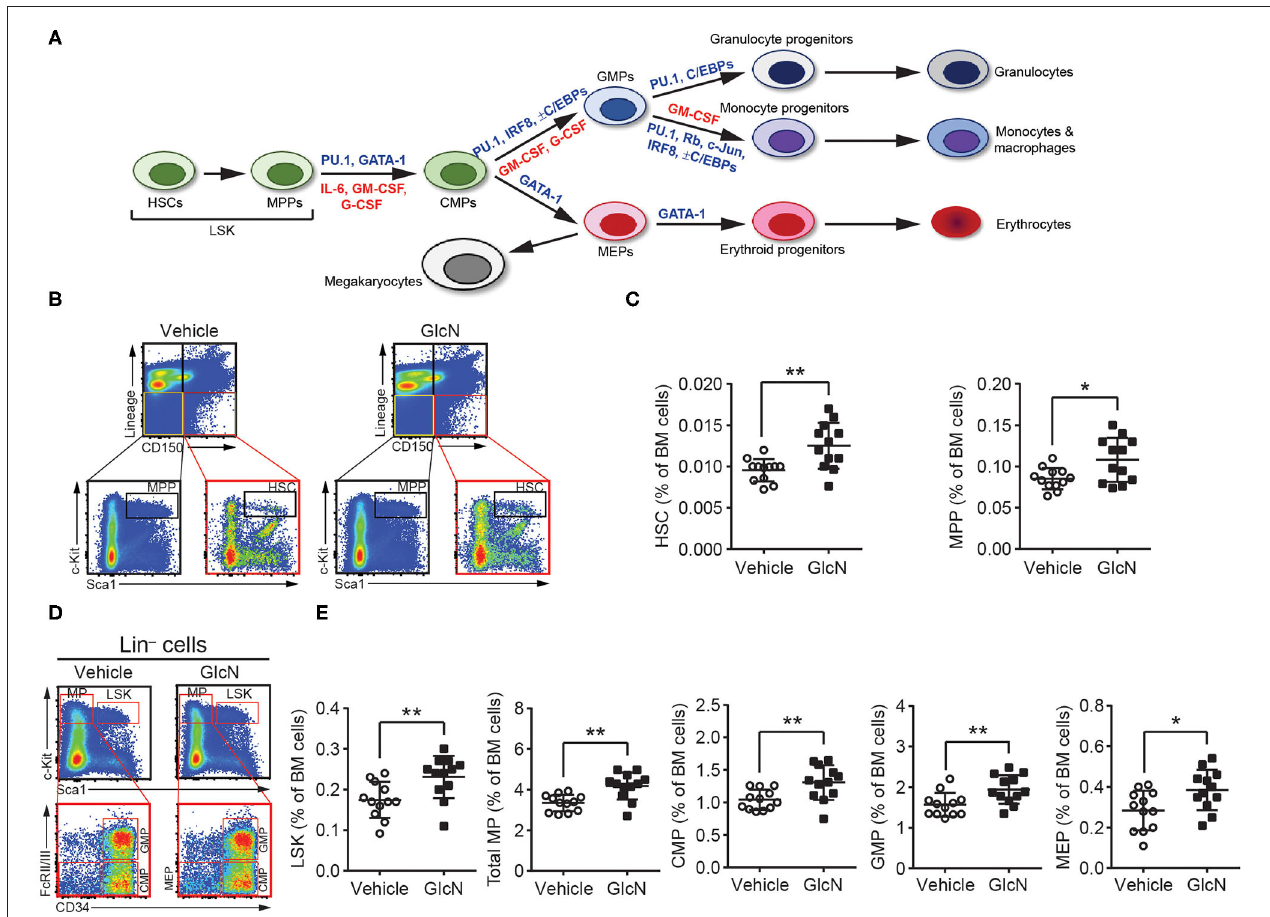
FIGURE 3 | GlcN increases hematopoietic stem and progenitor cell compartment. (A) Schematic of hematopoietic hierarchy and critical transcriptional factors and cytokines in myelopoiesis. (B) Schematics of identifying hematopoietic stem cells (HSCs) and multipotent progenitor cells (MPPs). (C) The frequency of HSCs and MPPs in BM after i.p. injection. (D) Schematics of identifying Lin − c-Kit + Sca-1 + cells (LSKs), total myeloid progenitors (MPs, Lin − c-Kit + Sca-1 − ), common myeloid progenitors (CMPs, Lin − c-Kit + Sca-1 − CD34 + FcRII/III − ), granulocyte-macrophage progenitors (GMPs, Lin − c-Kit + Sca-1 − CD34 + FcRII/III + ) and megakaryocyte-erythroid progenitors (MEP, Lin − c-Kit + Sca-1 − CD34 − FcRII/III − ). (E) The frequency of LSKs, MPs, CMPs, GMPs and MEPs in BM after i.p. injection. The quantified results are presented as the mean ± standard deviation. * P < 0.05; ** P <